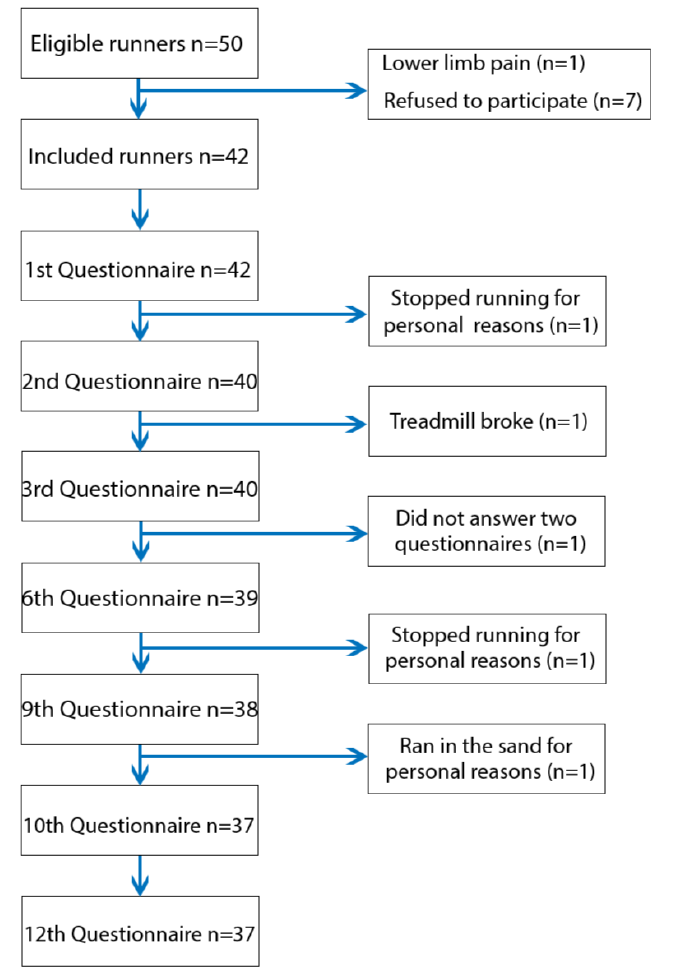
Figure 6 - Flowchart of the inclusion process and follow-up of the study.